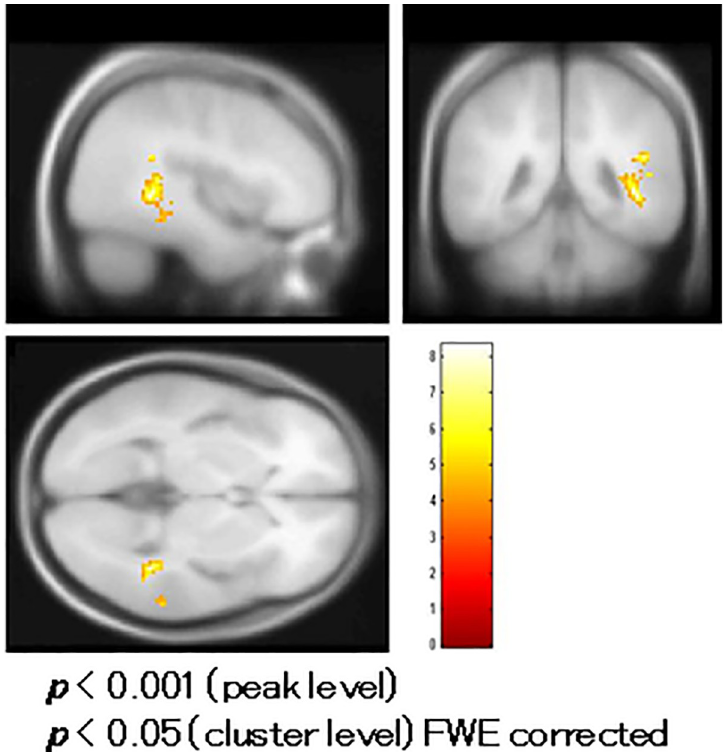
Fig 7. Correlation of functional magnetic resonance imaging (fMRI) with the PANSS in patients. Blood oxygenation level-dependent (BOLD) activity in the right parahippocampal gyrus correlated with the Positive and Negative Syndrome Scale (PANSS) positive symptom subscale